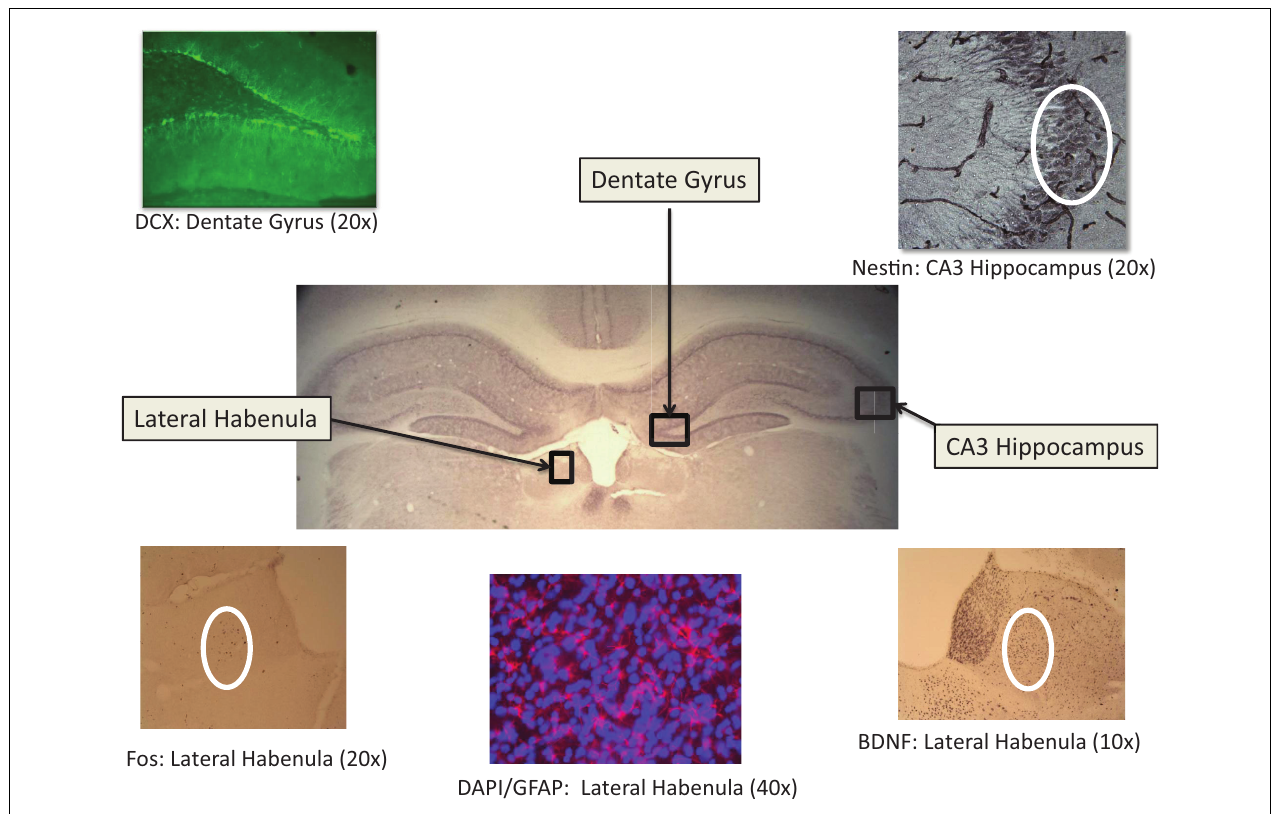
FIGURE 2 | Representative photomicrographs of relevant immunoreactive tissue in the lateral habenula and hippocampus (dentate gyrus and CA3 area. See Results for statistical findings for each area.